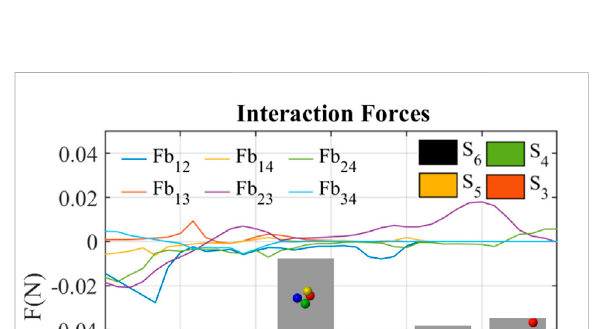
FIGURE 8 Interaction forces between balloons during lose-lose behavior led by interaction forces ( B 6 ).